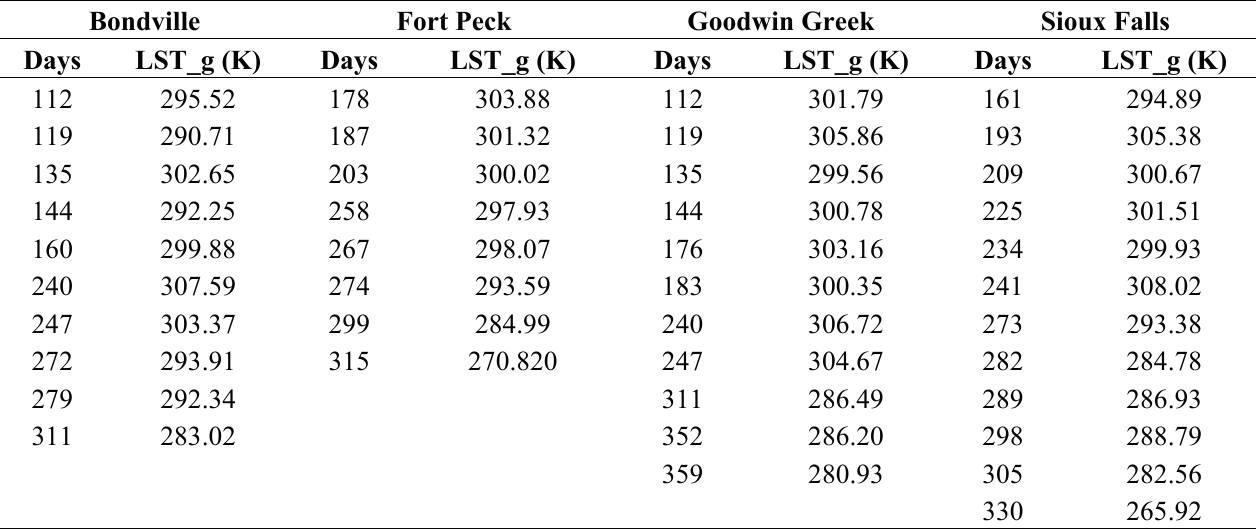
Table 6. Land Surface Temperature (LST) (LST selected sites for 41 scenes.